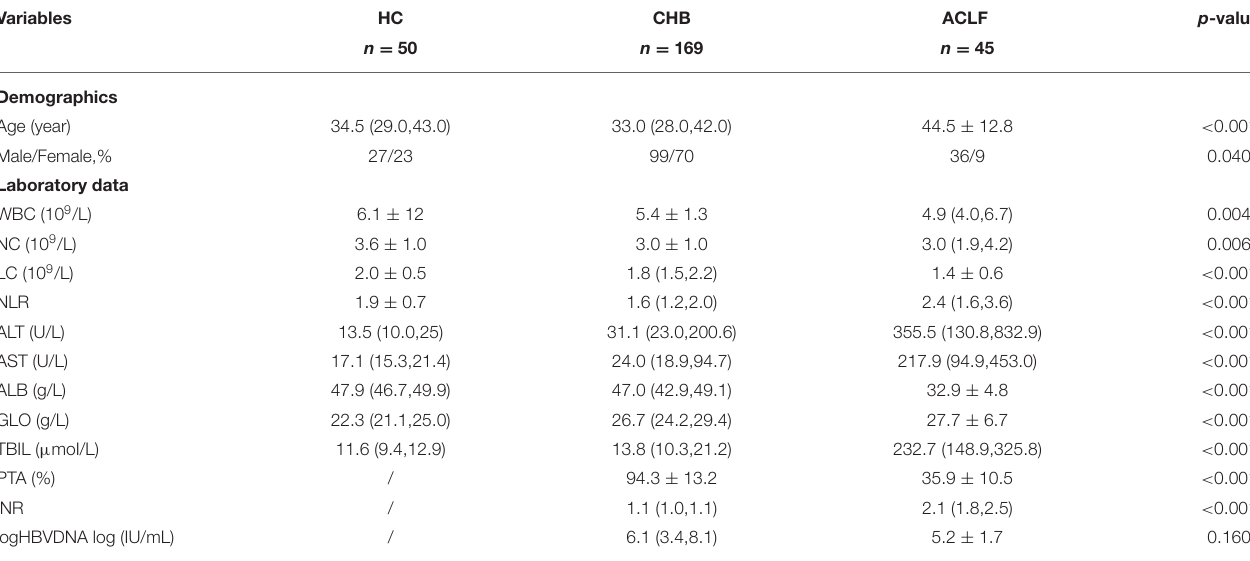
TABLE 1 | Characteristics of the subjects included in the